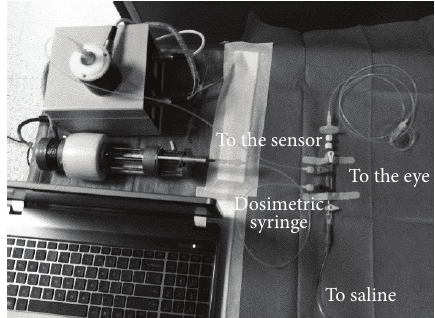
Figure 1: Setup of the system for the intraoperative measurement of ocular rigidity and outflow